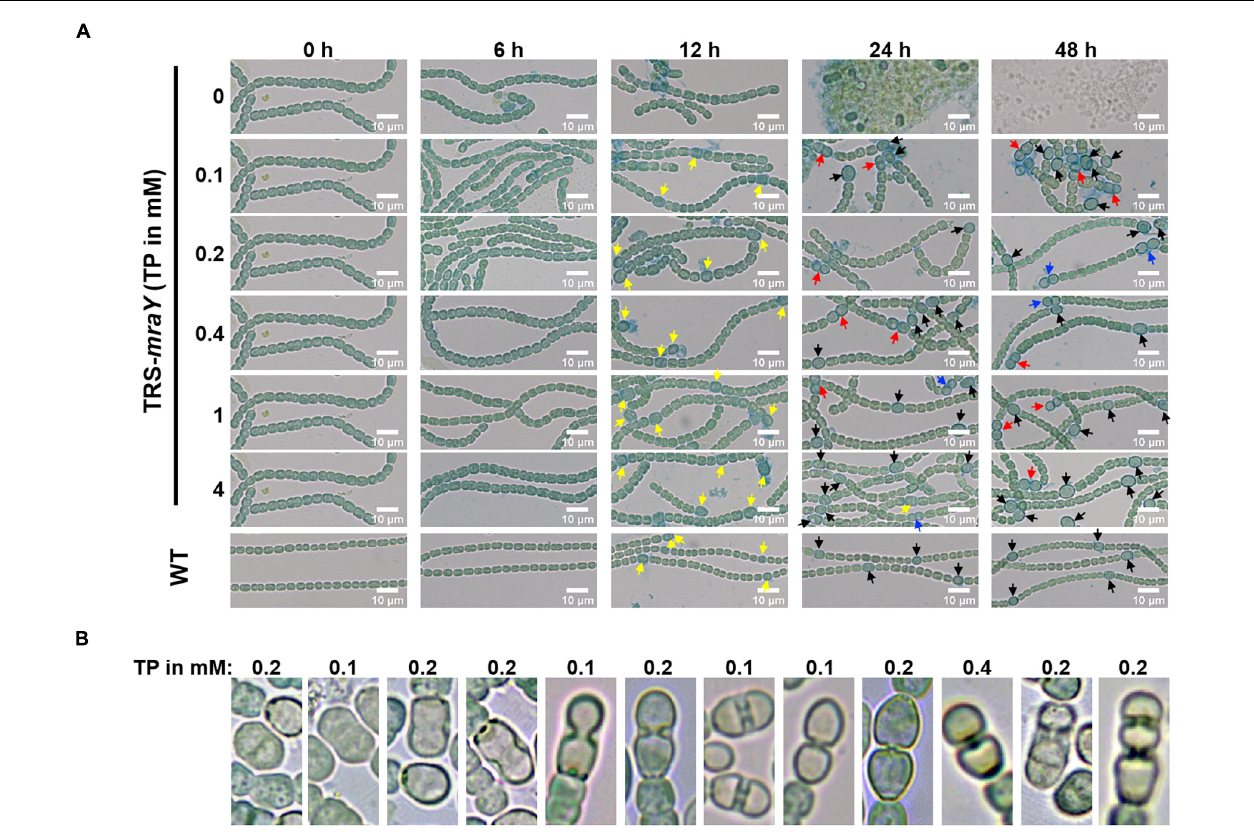
FIGURE 7 | Heterocyst differentiation of TRS- mraY in BG11 0 under permissive and non-permissive conditions. Samples of cell suspensions were directly observed under a light microscope and photographed at the indicated time. WT was used as the control. (A) Filaments of strain TRS- mraY grown in BG11 medium with 1 mM of TP were collected and transferred to BG11 medium without TP for 12 h ( Supplementary Figure 6 ) to remove TP. Then filaments were collected and transferred to BG11 0 medium with different concentrations of TP, in which they were incubated for indicated hours. Alcian blue stains exo-polysaccharides of proheterocysts or heterocysts. Yellow arrow, immature or proheterocysts; red arrow, aberrant heterocysts; blue arrow, double heterocysts; black arrow, mature heterocysts. (B) The morphology of aberrant heterocysts of strain TRS- mraY grown in BG11 0 medium with different concentrations of